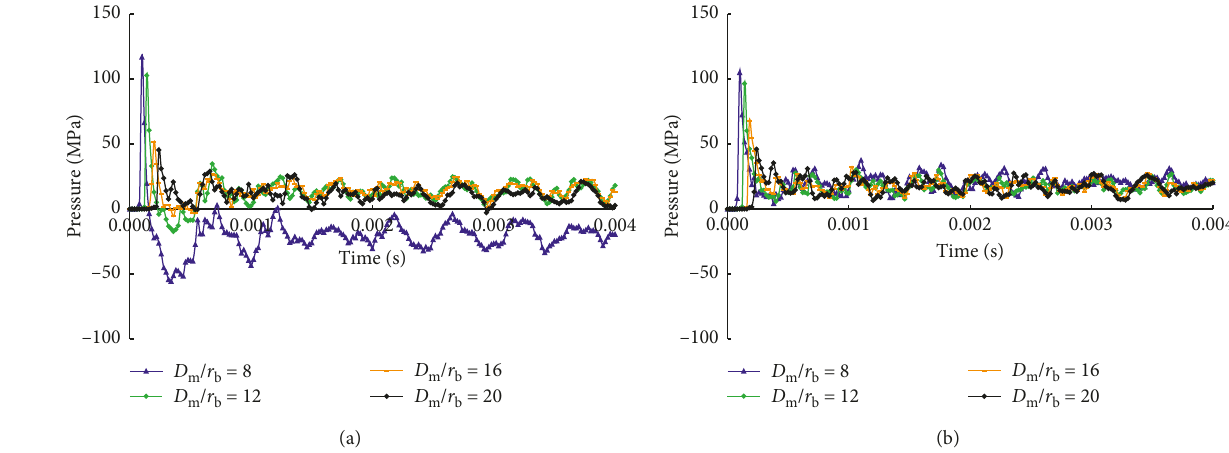
Figure 14: P-T curve of different monitoring points of #2 simulation case: (a) α